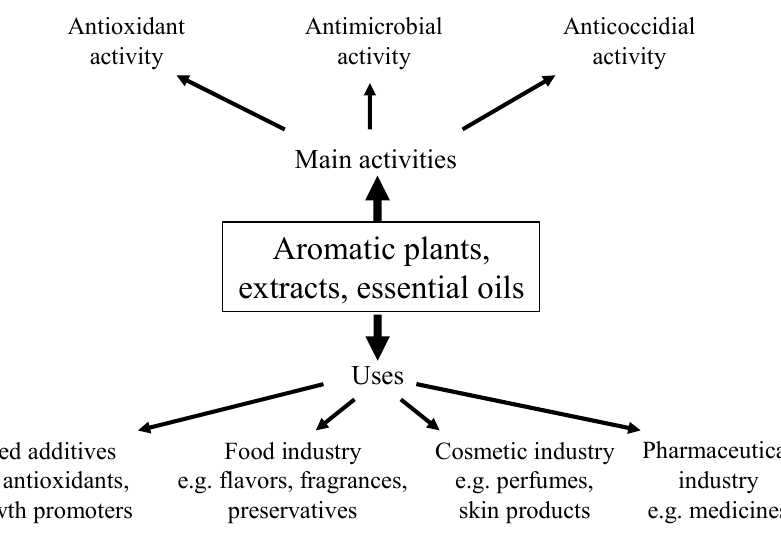
Figure 1. Activities and uses of aromatic plants.